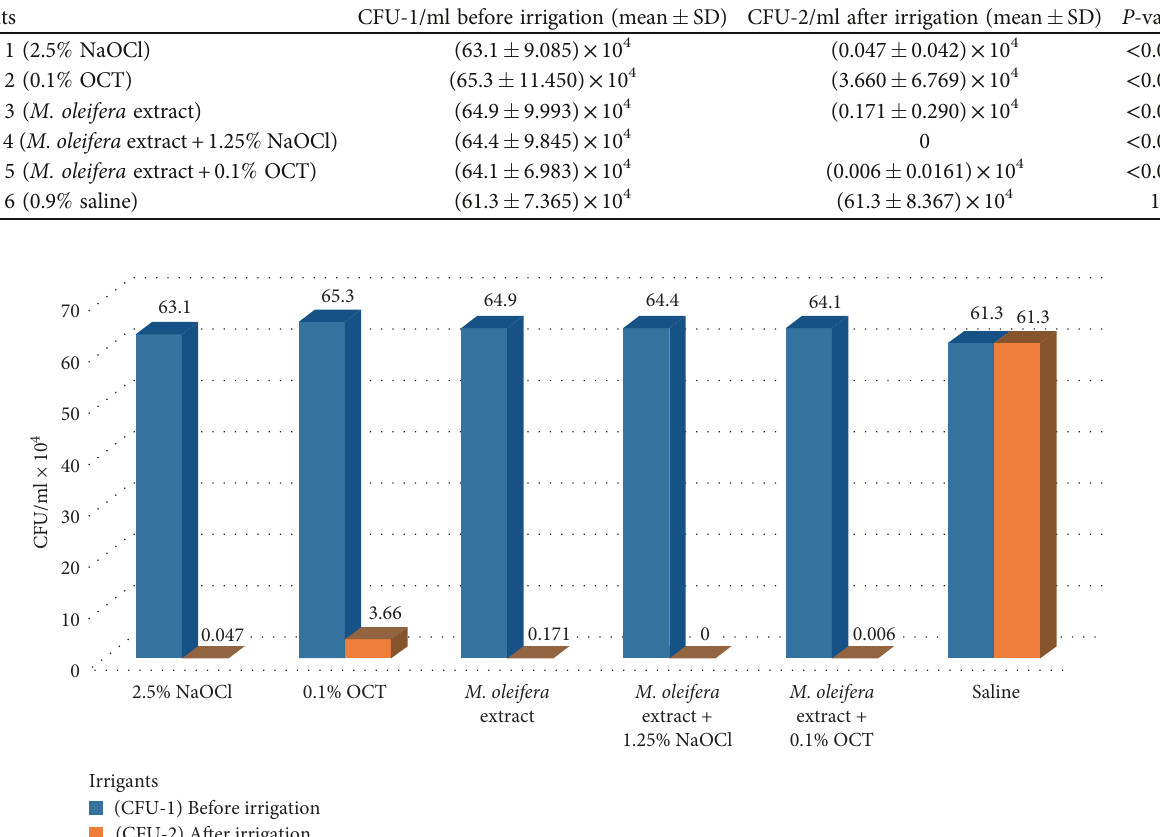
F IGURE 5: The comparison between CFU/ml of E. faecalis in the tested groups before (CFU-1) and after (CFU-2) application of the irrigants.